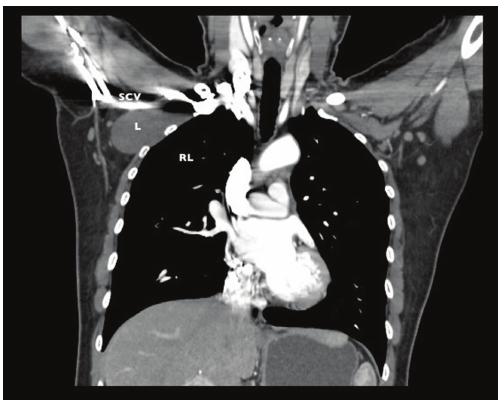
Figure 3: Chest CT with intravascular contrast, coronal view. L: lymphocele; RL: right lung; SCV: subclavian vessels.